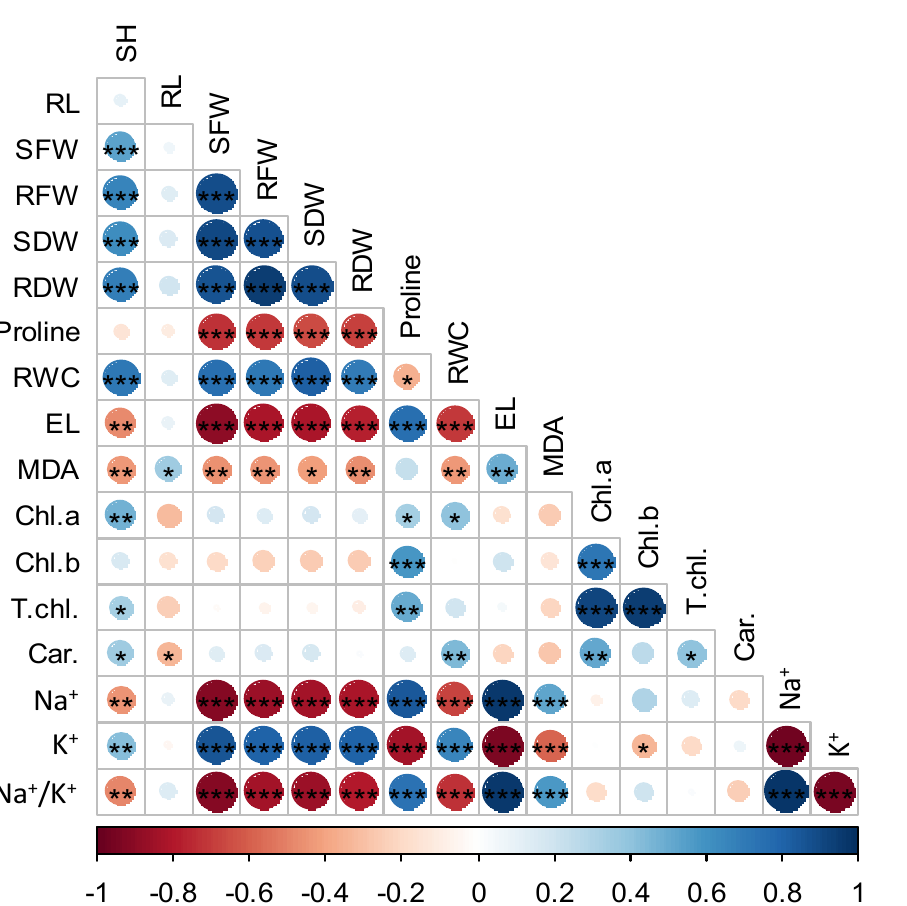
Figure 5. Pearson correlation matrix for different growth and physiological attributes of Si supple-